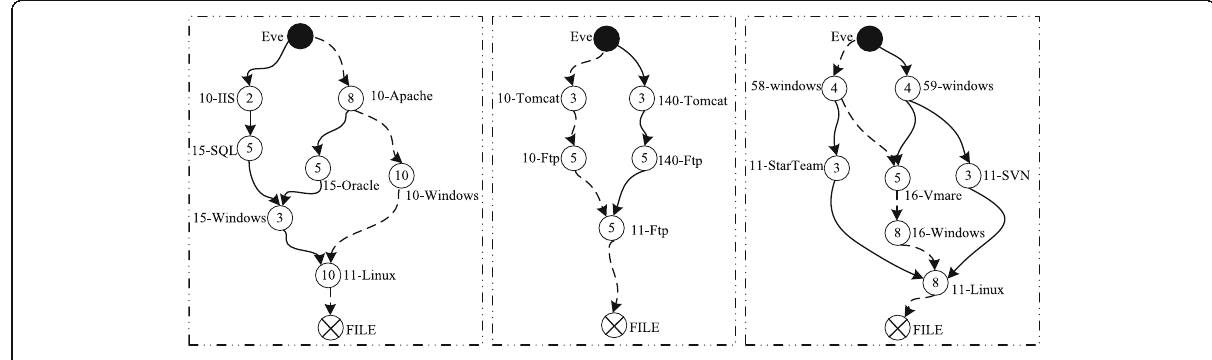
Fig. 13 Inference analysis results of experimental network diagram